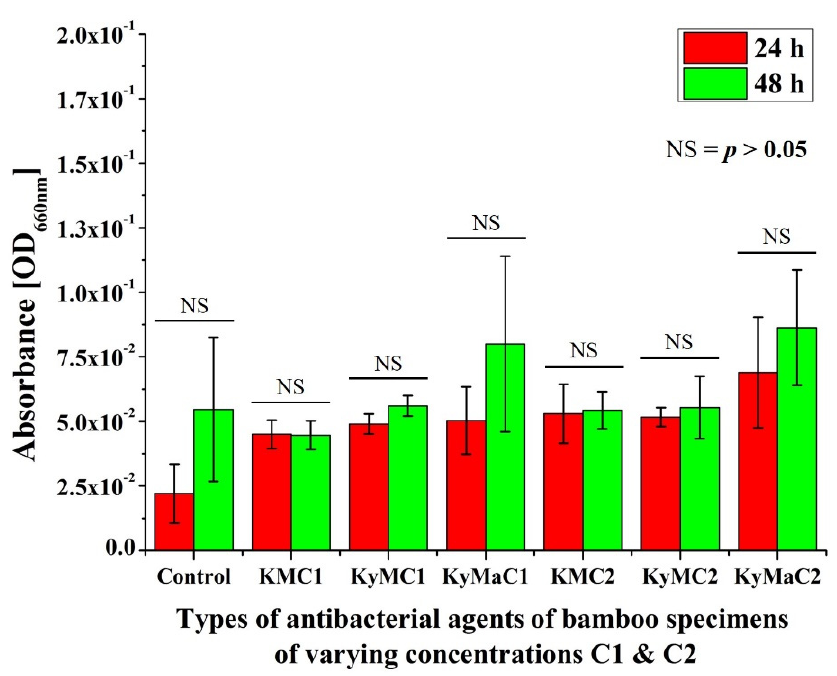
Figure 3. Absorbance results of various types of antibacterial agents of bamboo specimens of differing concentrations, C1 and C2, after in vitro testing with E. coli for a 24- and 48-h periods (* statistically significant difference, NS = no significant difference).